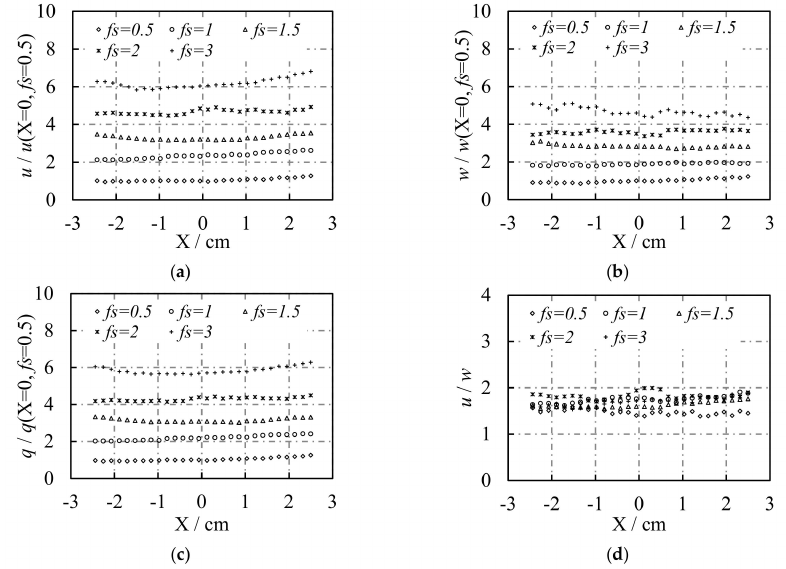
Figure 13. Turbulent intensity level (nondimensionalized using their reference values at X = 0, fs = 0.5 cm / s) under di ff erent strokes and frequencies: ( a ) u component; ( b ) w component; ( c ) q ; ( d ) u / w